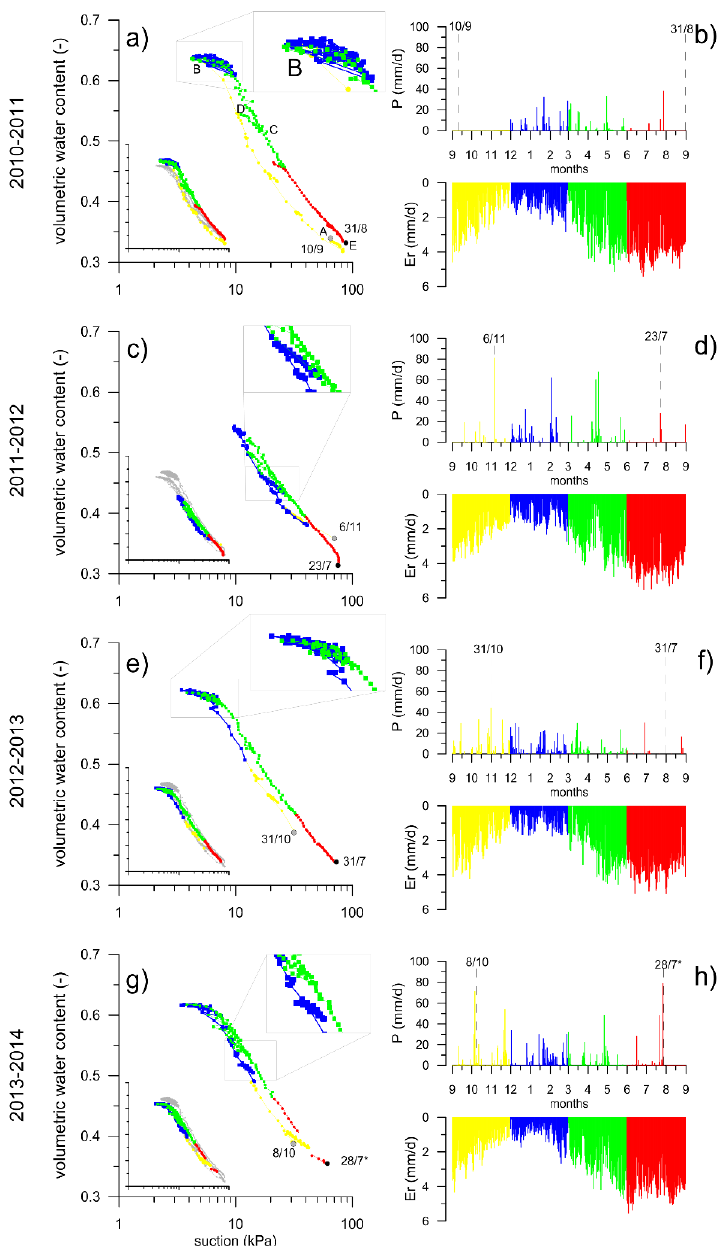
Figure 4. First column ( a - c - e - g ): matric suction – volumetric water content paths observed at depth of 50 cm over four hydrological years: yellow = fall – SON (September-October-November), blue = winter – DJF (December-January-February), green = spring – MAM (March-April-May), black, red = summer – JJA (June-July-August); in the box, readings made in other years and zooms of key paths are also reported. Second column ( b-d-f-h ): daily precipitation and reference evaporation assessed through the FAO approach: yellow = fall – SON, blue = winter – DJF, green = spring – MAM, red = summer – JJA.